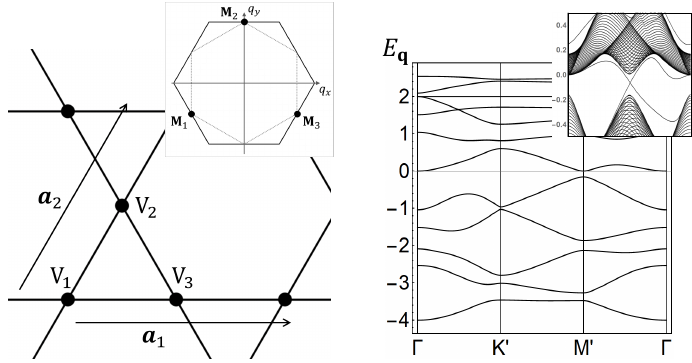
Figure 1: Left panel: The kagome lattice, where the Vanadium sits on sublattice sites V α = with the primitive lattice vector a 1,2,3 constant a = 1. (Inset: The BZ with vHS points, M α .) Right panel: Chiral flux phase band structure for t = 1, | Φ ασ | = 0.3. Due to the extended 2 × 2 unit cell, the BZ is folded with 12 bands per spin. Here, K ′ = ( 2 = 0 for case (i) in Eq. spectrum near E q